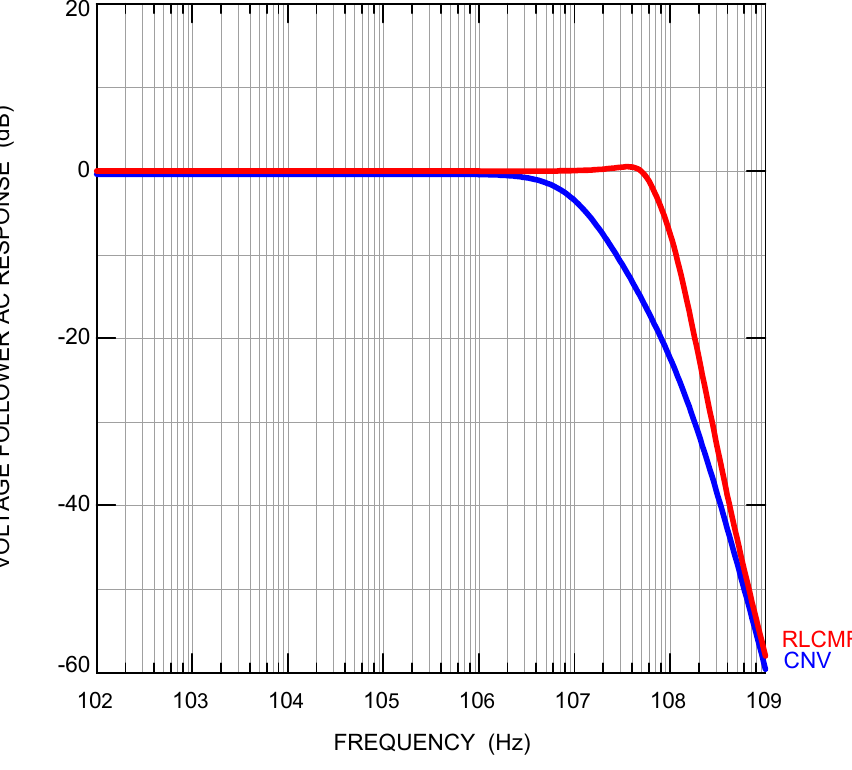
Figure 5. Voltage follower AC responses of circuits of Figure 3.